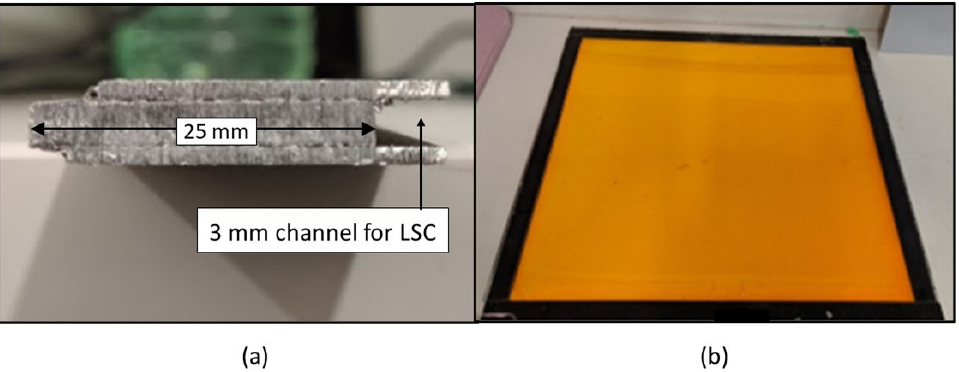
Figure 2. ( a ) Cross-section of the aluminum absorber used as the luminescent solar concentrator (LSC) module frame. ( b ) The assembled orange LSC module.